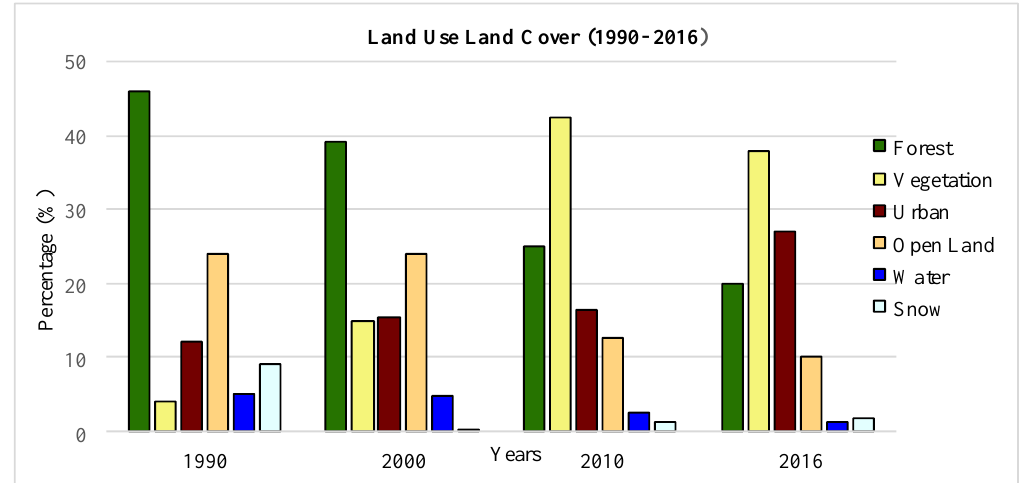
Figure 4 Spatiotemporal change of each LULC class from 1990 to 2016